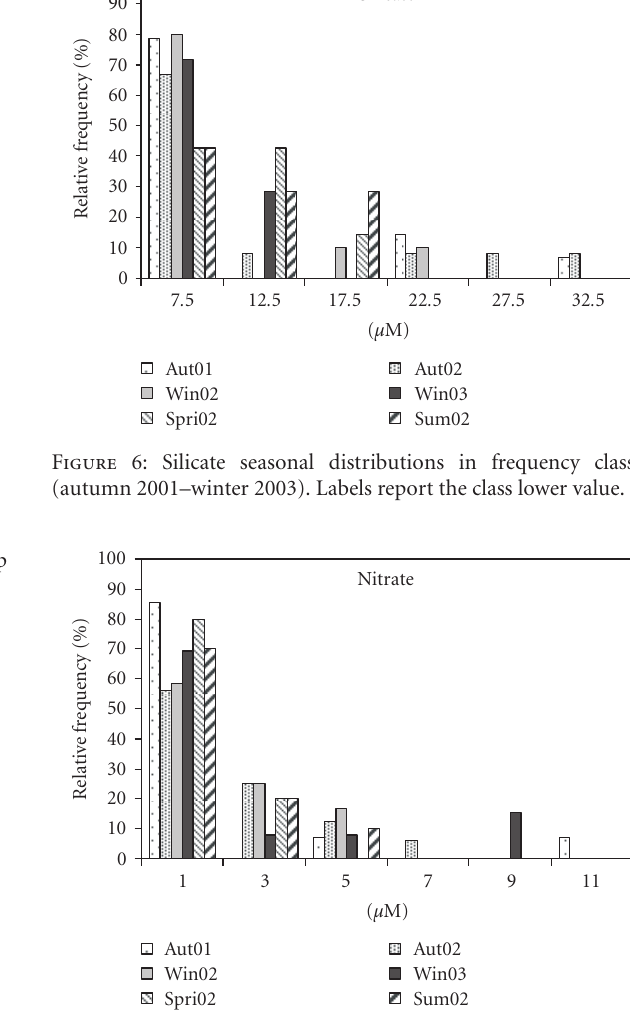
Figure 7: Nitrate seasonal distributions in frequency classes (autumn 2001–winter 2003). Labels report the class lower value. higher classes of values show relative frequencies higher than